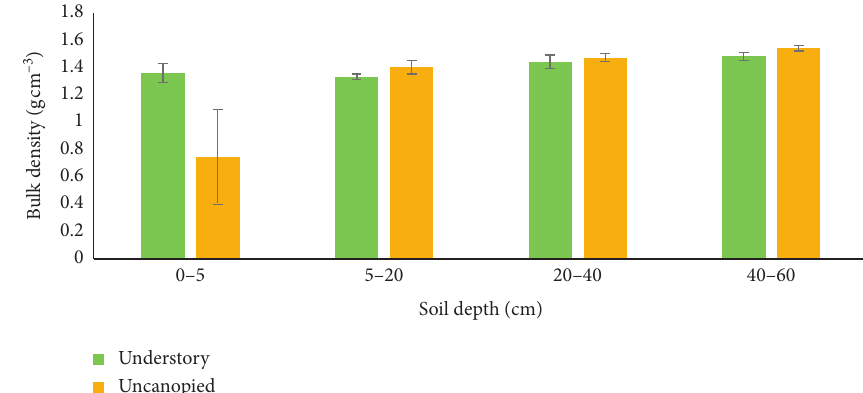
Figure 3: Soil bulk density in the understory of mesquite trees and the uncanopied adjacent areas.